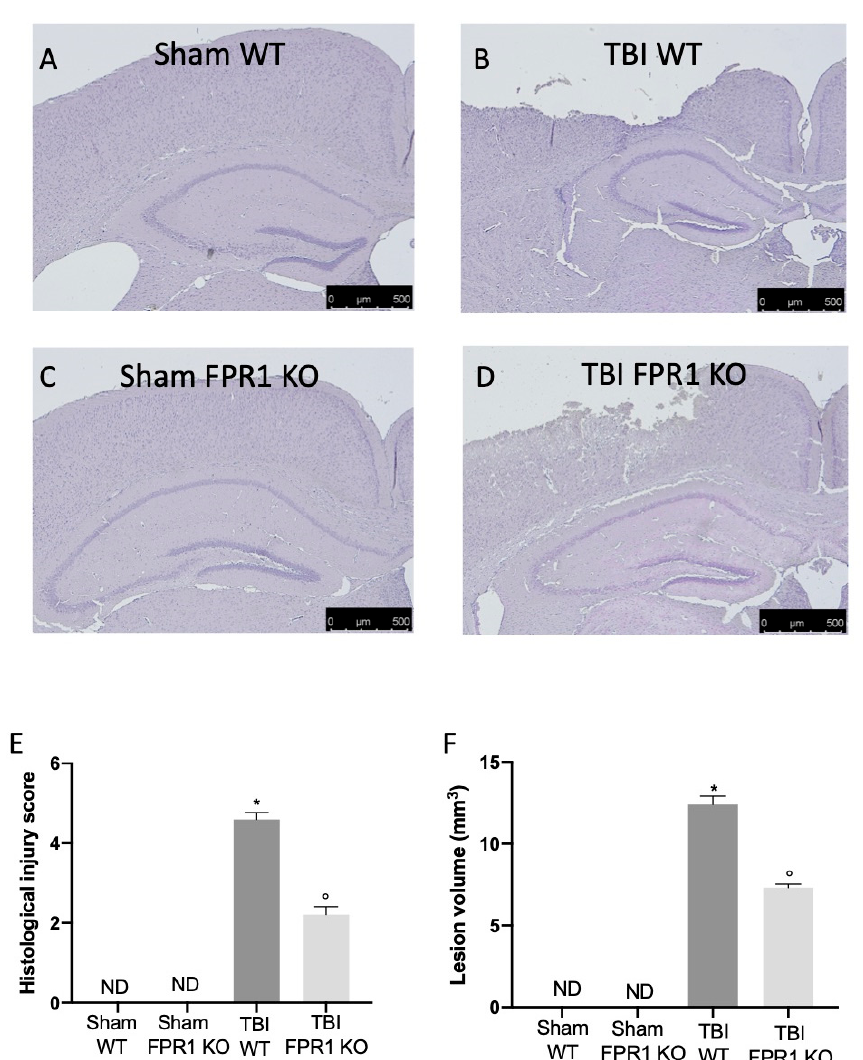
Figure 10. Effect of the absence of Fpr1 on histological alterations: No histological alterations were detected in brain section from mice of the Sham WT group ( A ) and Sham Fpr1 KO group ( C ). The TBI WT group four weeks after injury shows evident tissue inflammation ( B ). ( D ) Fpr1 KO animals subjected to TBI show less injury than the TBI WT group ( E ) Moreover, the TBI Fpr1 KO group displays a reduced lesion volume compared to the TBI WT group, as shown in ( F ) For the analyses, n = 5 animals from each group were employed. Results were analyzed by two-way ANOVA followed by a Bonferroni post-hoc test for multiple comparisons. Non-parametric data were analyzed with Fisher’s exact test. * p < 0.05 vs. Sham WT; ° p < 0.05 vs. TBI WT. scale bar 500 μ m.